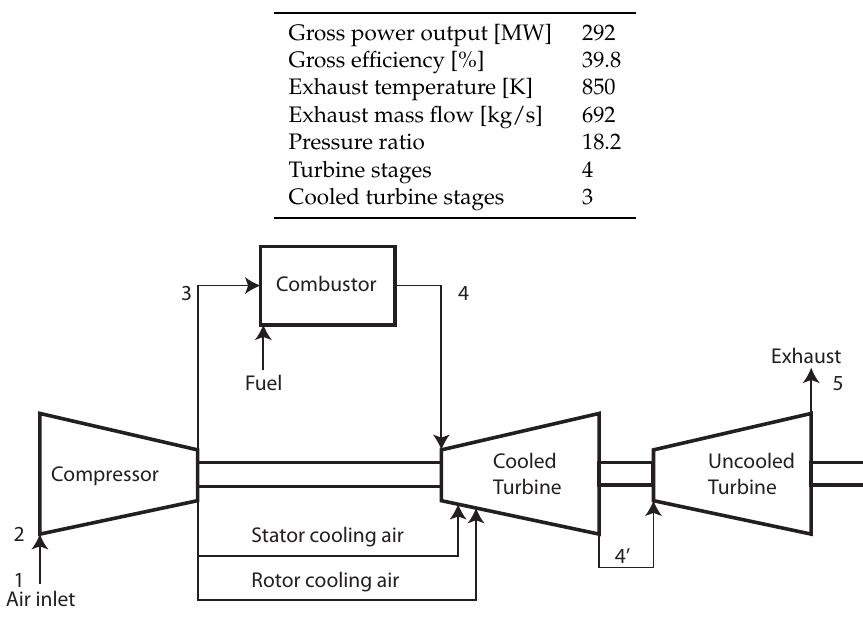
Table 2. Reference gas turbine design and operational data.